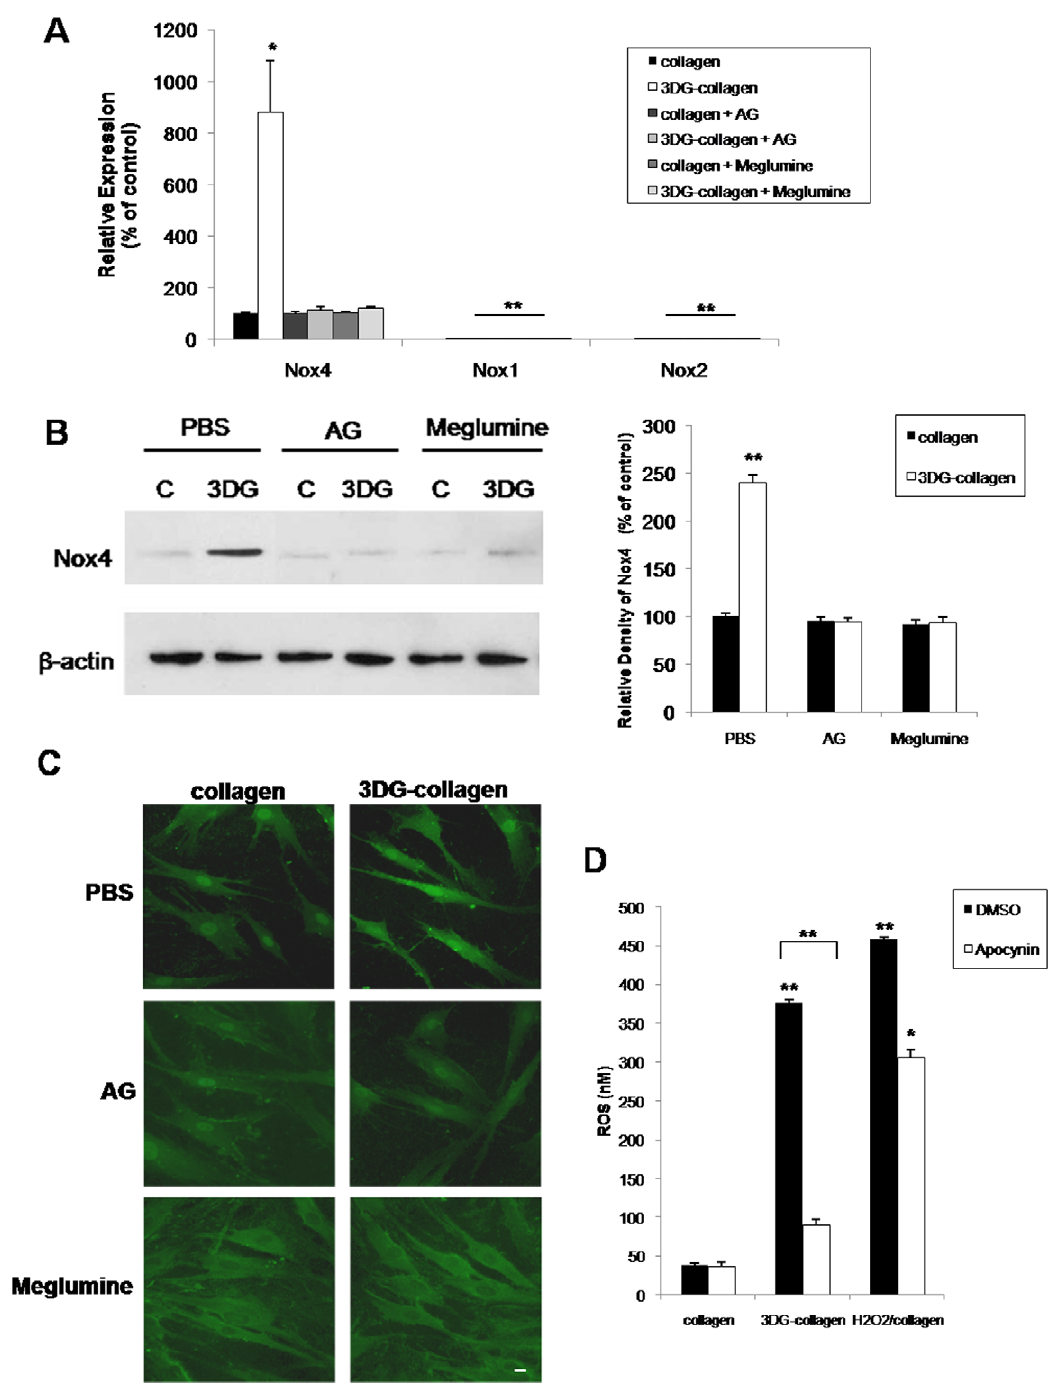
Figure 4. 3DG-collagen increases expression of Nox4 in the dermal fibroblast. Fibroblasts were cultured on either native collagen or 1 mM 3DG-collagen and treated with or without 5 mM AG or 40 mM meglumine for 24 h. A , Nox4, Nox1, and Nox2 mRNA expression levels were quantified by real-time PCR. All transcripts were normalized to b -actin. B , Expression levels of Nox4 were analyzed by Western blot and b -actin served as a loading control. Results were quantified by densitometric scanning of the Western blot and normalized for b -actin. C , Localization of Nox4 in fibroblasts treated the same as in A and B was analyzed by immunofluorescence with the anti-Nox4 polyclonal antibody and Cy2-conjugated secondary antibody. Images were taken at 40 6 magnification on an epi-fluorescence microscope. Scale bar represents 10 m m. D , Inhibition of Nox4 reduces the level of intracellular ROS. Fibroblasts were pretreated for 1 h with either vehicle, DMSO or NOX inhibitor, apocynin (1 mM) and cultured on native collagen, 1 mM 3DG-collagen, or cultured on native collagen and treated with 50 m M H 2 O 2 for 24 h. Fibroblasts were then incubated with DCFH-DA for 30 min and the level of intracellular ROS was determined by measuring the fluorescence at 480 nm/530 nm. Comparisons are made against collagen treated with DMSO and/or PBS unless otherwise indicated. Data are mean 6 SD (n=3), **P , 0.001, *P , 0.02.